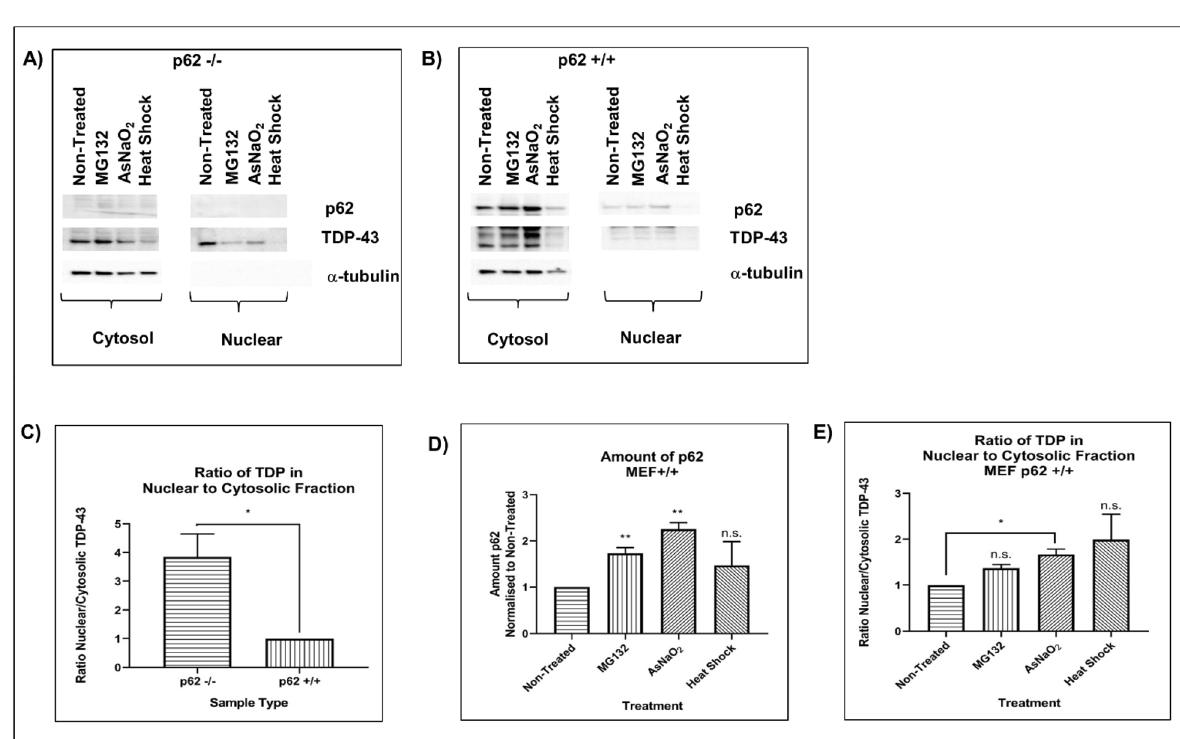
Figure 3. p62 alters the nuclear:cytoplasmic TDP-43 ratio. Mouse embryonic fibroblasts ( A ) with p62 knockdown (p62 −/− ) and ( B ) without (p62 +/+ ) were treated with proteasome inhibitor (MG132), sodium arsenate or heat shock followed by recovery. Cells were fractionated into nuclear and cytosol fractions and proteins separated by SDS polyacrylamide gel electrophoresis. Western blots for endogenous p62, TDP-43 and α-tubulin were performed. ( C ) The ratio of nuclear: cytoplasmic TDP-43 in non-treated p62 −/− cells presented as a fold- change normalised to p62 +/+ non-treated cells (set to 1.0) and ( D ) the amount of p62 in p62 +/+ with indicated treatments. ( E ) The ratio of nuclear:cytoplasmic TDP-43 in treated p62 +/+ cells presented as a fold-change normalised to p62 +/+ non-treated cells (set to 1.0). Images are representative of 4 independent experiments. Data presented in ( C ), ( D ) and ( E ) are the mean +/− SEM of 4 independent